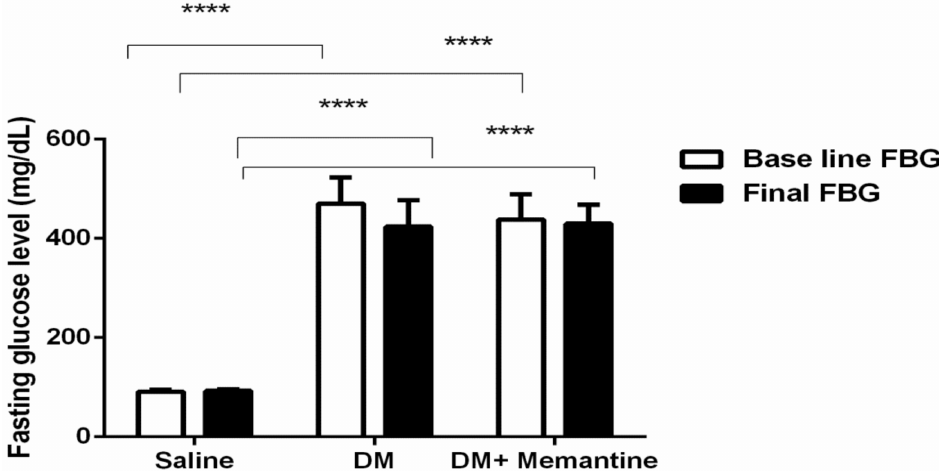
Figure 1. Effect of memantine on the blood glucose level. Fasting blood glucose was measured before memantine therapy and at the end of the experiment. The data are the mean ± standard deviation of the mean (SDM) and were analyzed by one-way ANOVA and Tukey’s tests. DM: diabetes mellitus mice, **** p < 0.0001 versus the saline group.